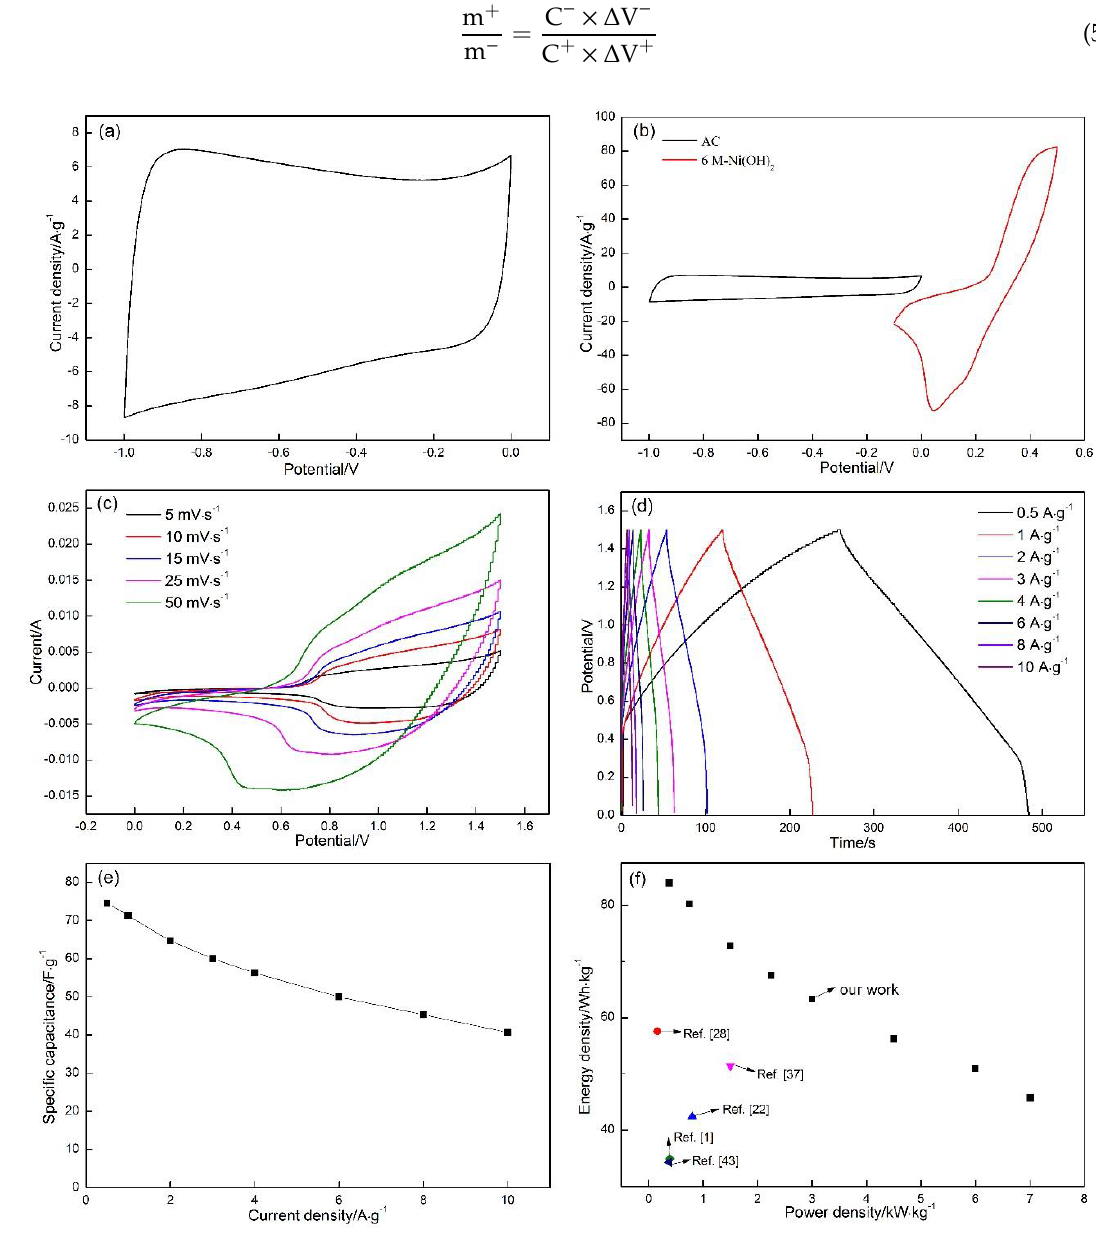
Figure 11. ( a ) CV curves of the active carbon (AC). ( b ) CV curves of the AC and 6 M-Ni(OH) 2 electrodes at 50 mV·s −1 . ( c ) CV curves of the HSC device tested at various scanning rates, of 5 mV·s −1 electrodes at 50 mV · s − 1 . ( c ) CV curves of the HSC device tested at various scanning rates, of 5 mV · s − 1 to 50 mV·s −1 . ( d ) Galvanostatic charge-discharge tests (GCD) curves of the 6 M-Ni(OH) 2 //AC HSC. ( e ) to 50 mV · s − 1 . ( d ) Galvanostatic charge-discharge tests (GCD) curves of the 6 M-Ni(OH) 2 // AC HSC. Specific capacitance of the 6 M-Ni(OH) 2 //AC HSC at different current densities. ( f ) Ragone plot of the ( e ) Specific capacitance of the 6 M-Ni(OH) 2 // AC HSC at di ff erent current densities. ( f ) Ragone plot of 6 M-Ni(OH) 2 //AC HSC. the 6 M-Ni(OH) 2 // AC